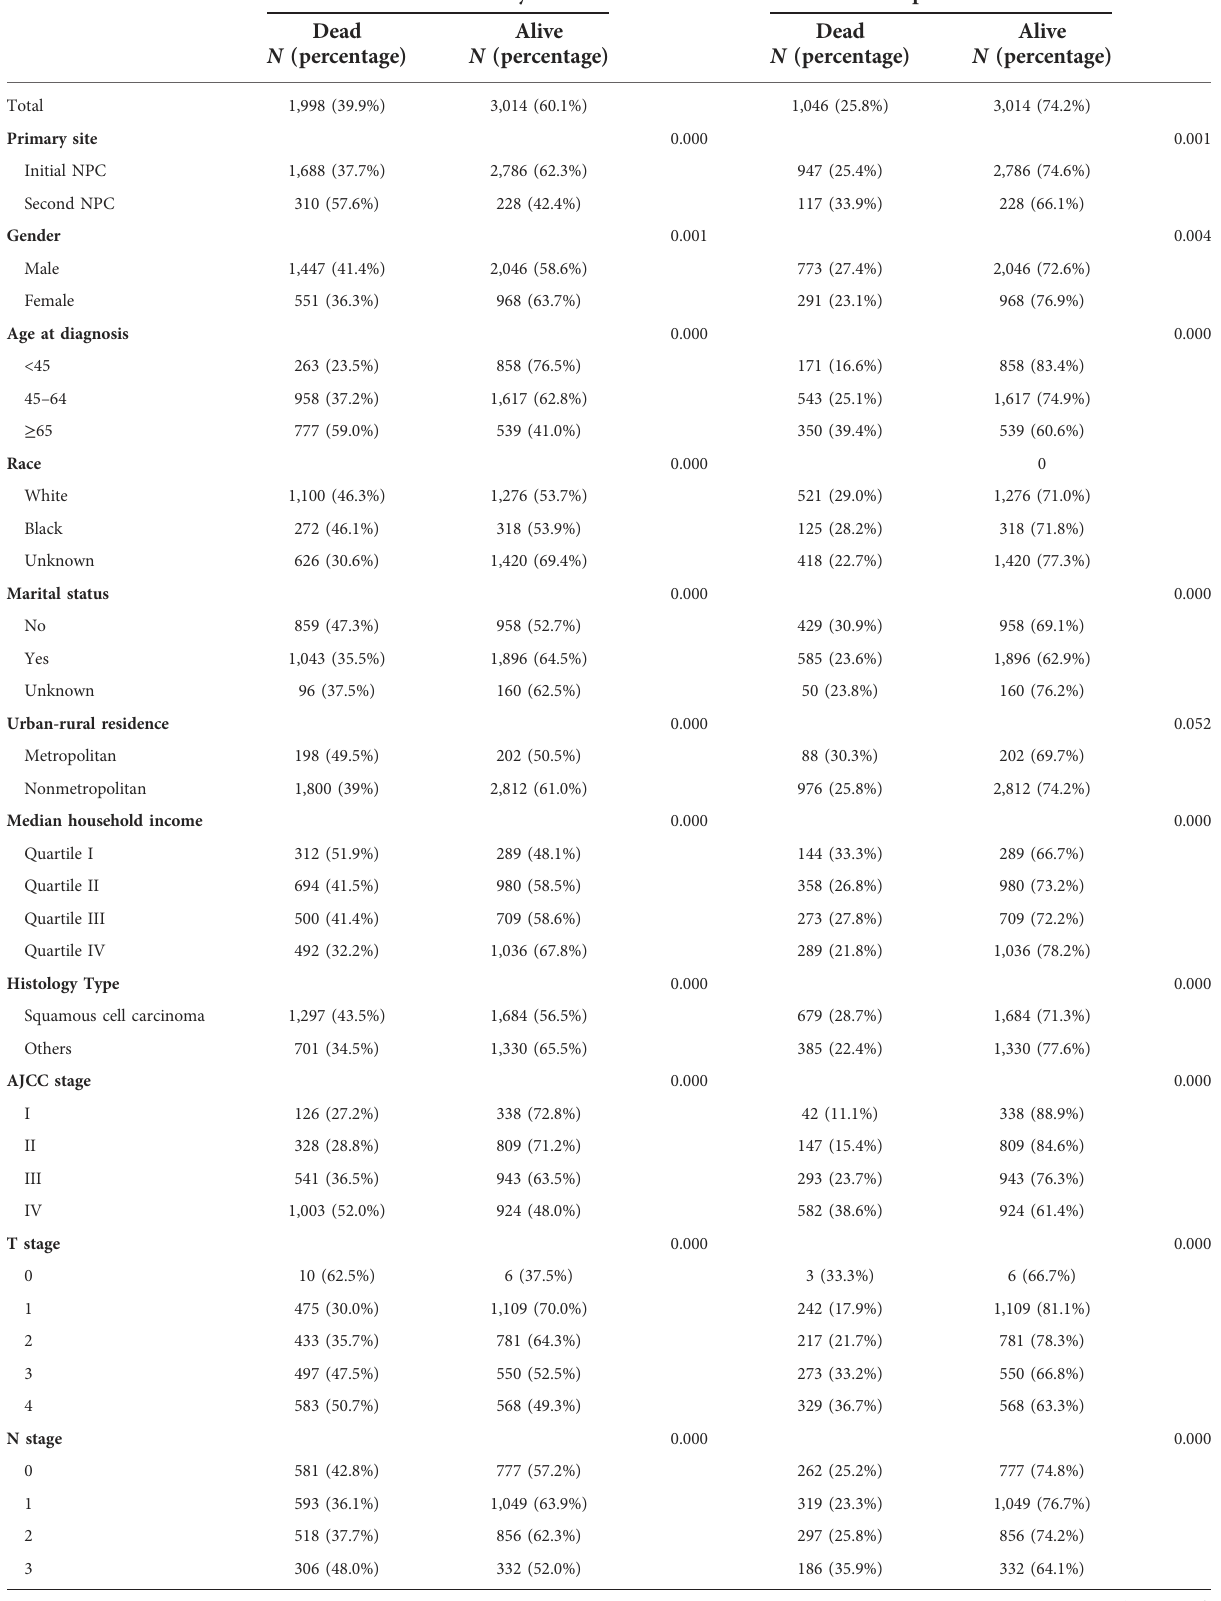
TABLE 2 Univariate analysis of all-cause and NPC-speci fi c mortality for NPC patients. Characteristic All-cause